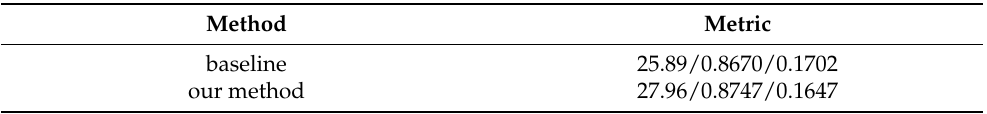
Table 2. Metric values (PSNR/SSIM/LPIPS) of the proposed method (HMM with the FM) and baseline (HMM without the